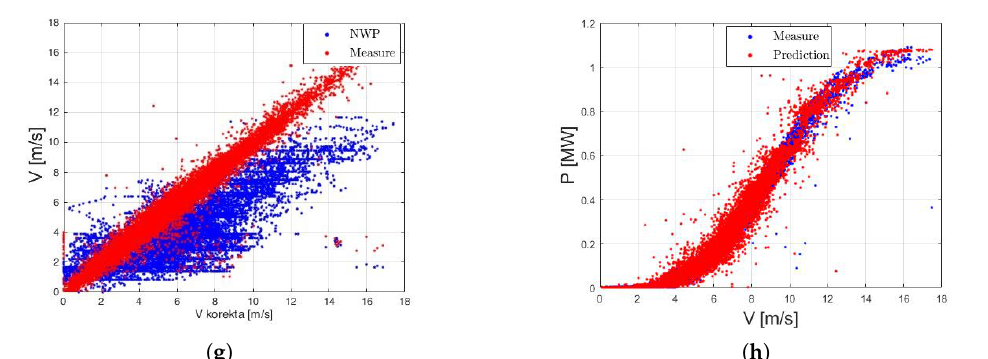
Figure 34. Measured and predicted output of the power plant. ( a ) Correlation characteristics of measured and predicted wind velocity—Network I. ( b ) Power characteristic of the power plant— Network I. ( c ) Correlation characteristics of measured and predicted wind velocity—Network II. ( d ) Power characteristic of the power plant—Network II. ( e ) Correlation characteristics of measured and predicted wind velocity—Network III. ( f ) Power characteristic of the power plant—Network III. ( g ) Correlation characteristics of measured and predicted wind velocity—Network IV. ( h ) Power characteristic of the power plant—Network